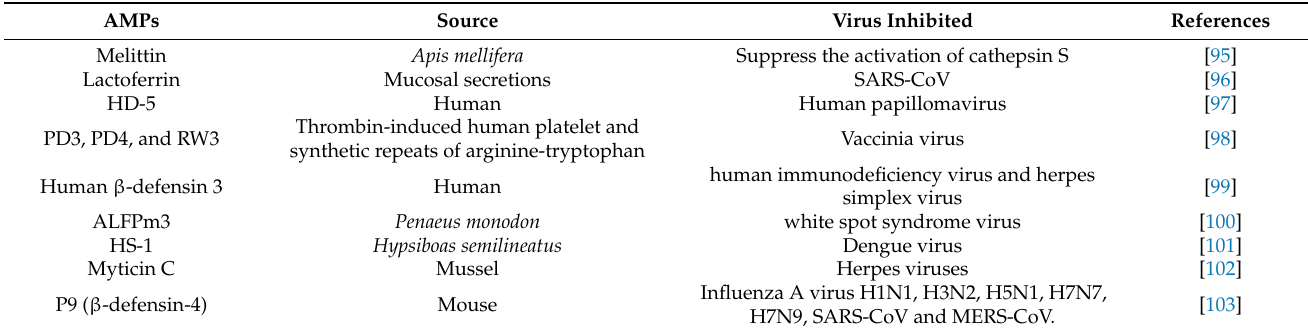
Table 4. List of some of the AMPs with putative antiviral activity.